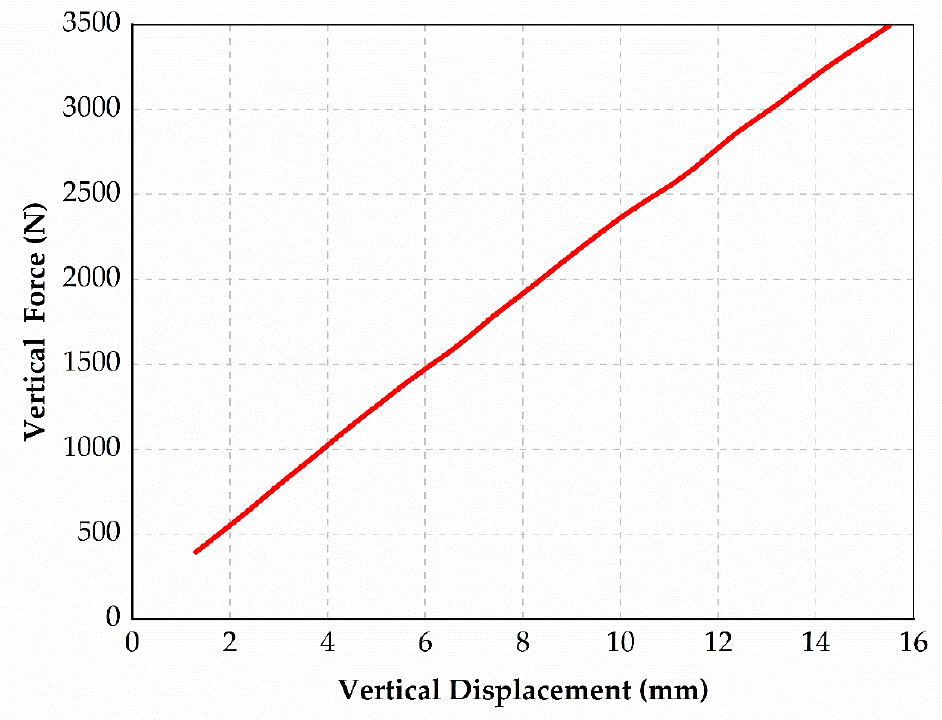
Figure 13. The vertical force vs. vertical displacement of the original pneumatic tire (175/70 R14).